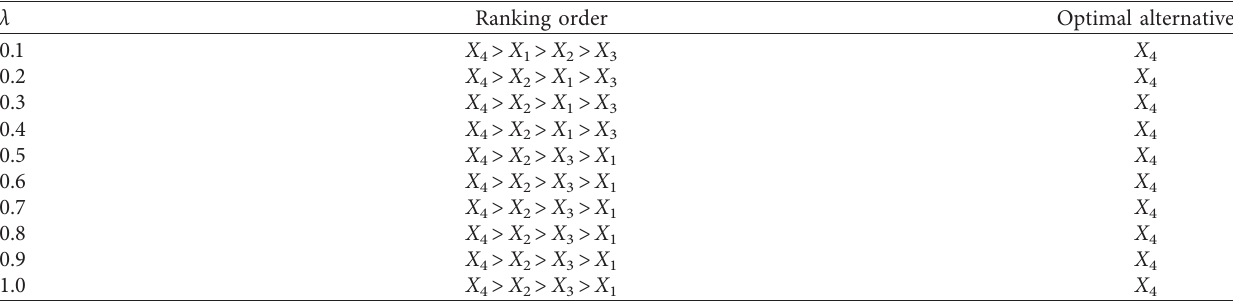
Table 12: Ranking results under different parameter λ .